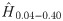
Wavelet and Fourier LF/HF ratios.The LF/HF ratio measured classically using spectral analysis is compared against the LF/HF ratio computed a posteriori using Eq (5) with the Hurst exponent H^0.04−0.40, estimated via the wavelet spectrum. The very satisfactory match between both LH/HF ratios is a strong evidence indicating a power-law shaped decay of the PSD of intrapartum fetal HRV time series.